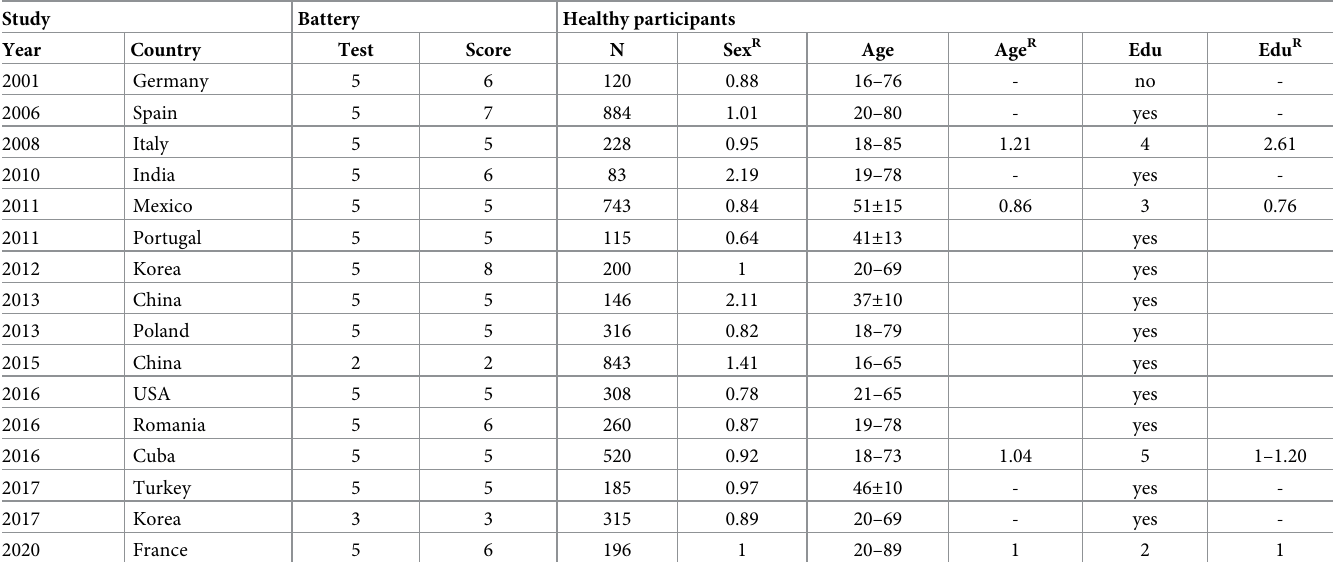
Table 1. Literature review of PHES in healthy participants.